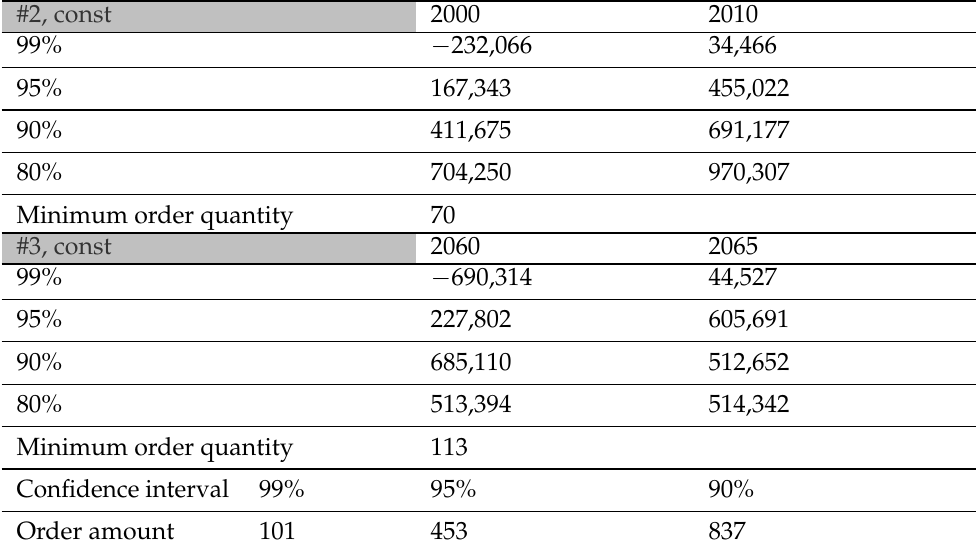
Table 6. The minimum value of the order quantity used in Equation (1) according to the con- stant value.